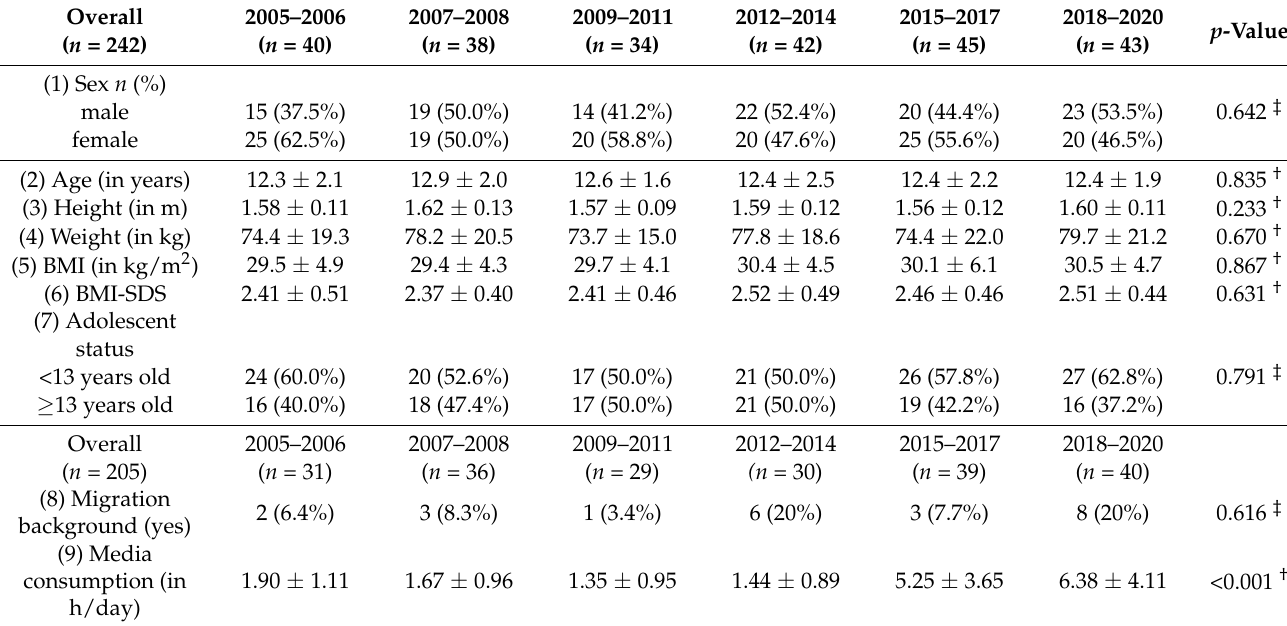
Table 2. Descriptive statistics separated by time period.